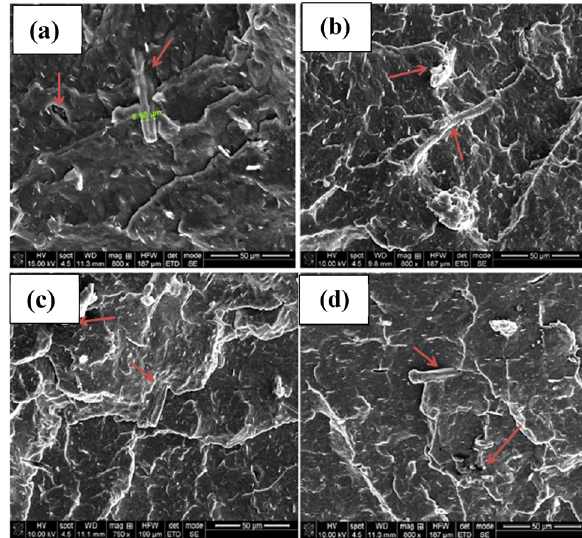
Figure 5: SEM images of fractured samples ( a ) PHB - MCC Ar, ( b ) PHB - MCC Ar/N 2 , ( c ) PHB - MCC Ar/O 2 , ( d ) PHB - MCC Ar/CAN. Adapted from ref. [ 47 ]